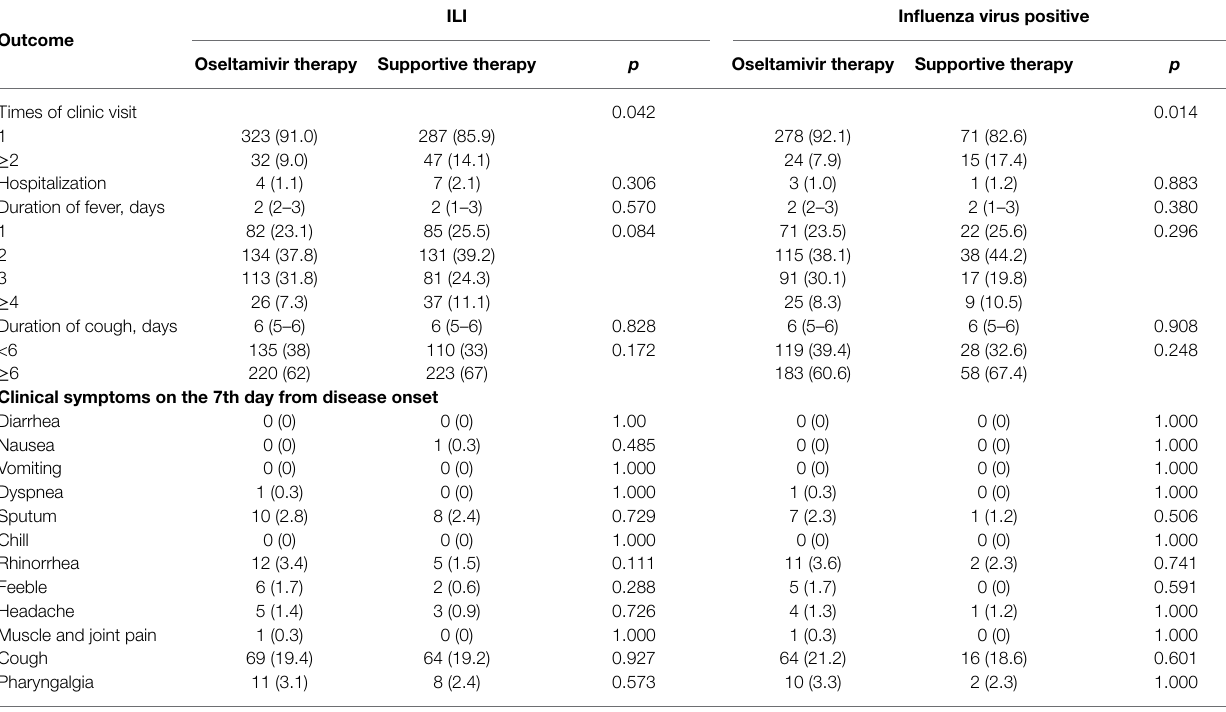
TABLE 3 | Outcomes of the ILI and influenza virus-positive patients with or without oseltamivir therapy.